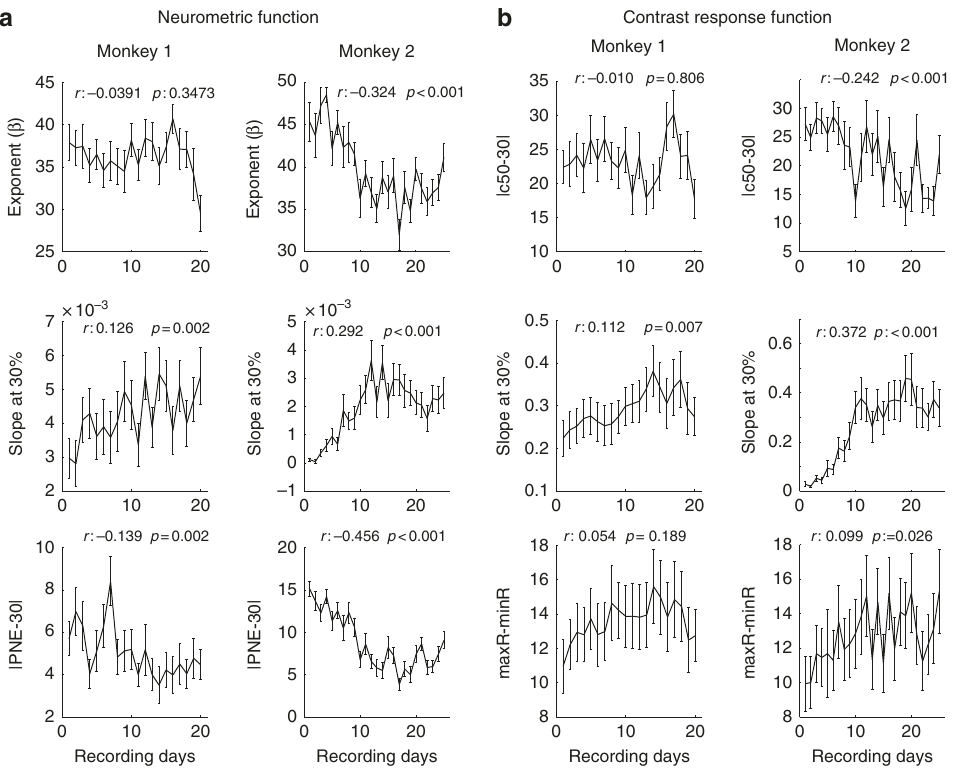
Fig. 2 Learning-induced changes in selected parameters of the neurometric function and of the contrast response function. a Changes in location where the neurometric function reaches 63% of its range, the slope at 30% contrast and point of neuronal equality of the neurometric function. b Changes in C 50 of the Naka Rushton function, its slope at 30% and rate ranges (difference between minimum and maximum measured activity). Insets show the Spearman rank correlation coef fi cients ( r ) and the p value ( p ) of the parameter of interest (dependent variable) vs. recording days (independent variable). Error bars show S.E.M. ( n = 29 and n = 20 per data point for monkeys 1 and 2,